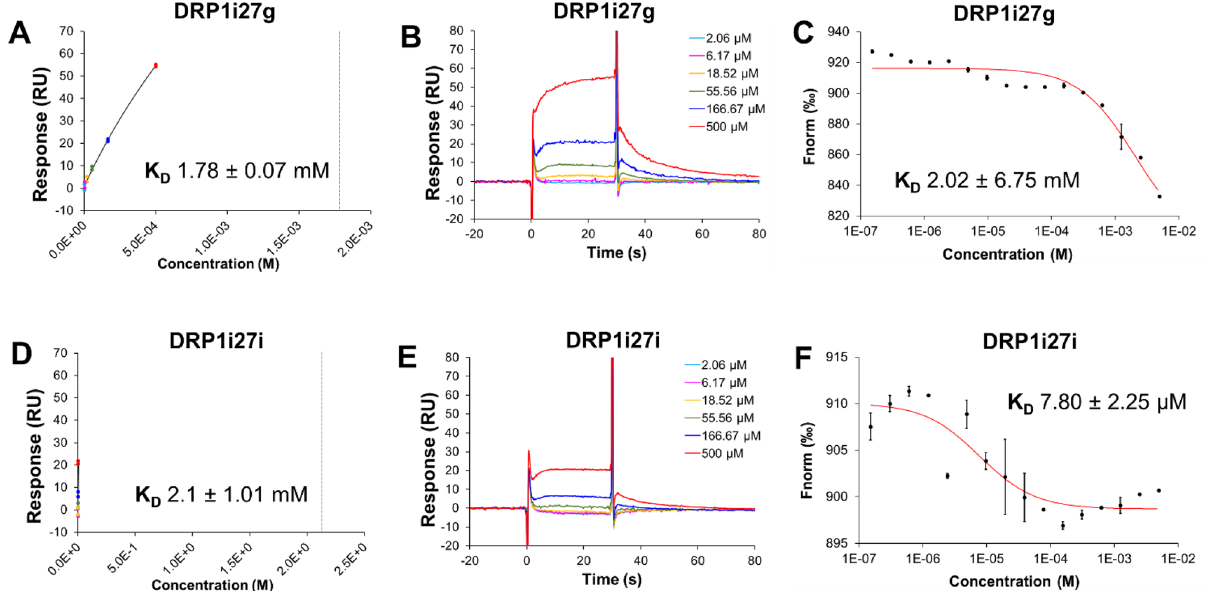
Figure 7. Binding affinity of DRP1i27 analogues toward human Drp1. Representative (A, B, D, E) SPR and (C, F) MST assay results of (A–C) DRP1i27g and (D–F) DRP1i27i. (n = 2). Data are expressed as mean ±